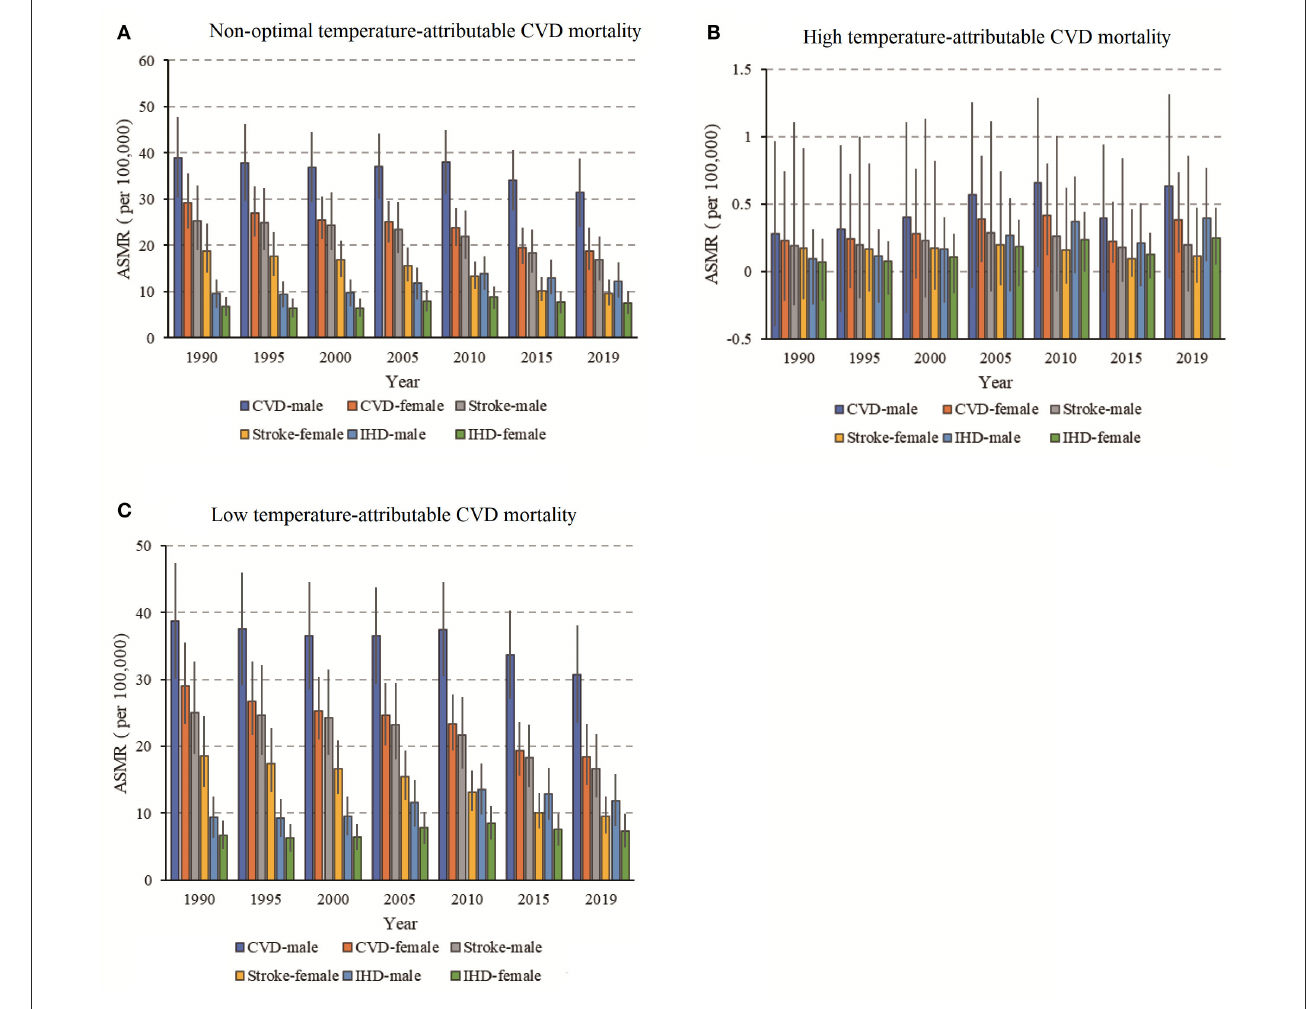
FIGURE1 The trends of age-standardized mortality rate (ASMR) for CVD (A) , stroke (B) , and IHD (C) mortality attributable to non-optimal temperatures during 1990–2019 and the corresponding 95% CI.